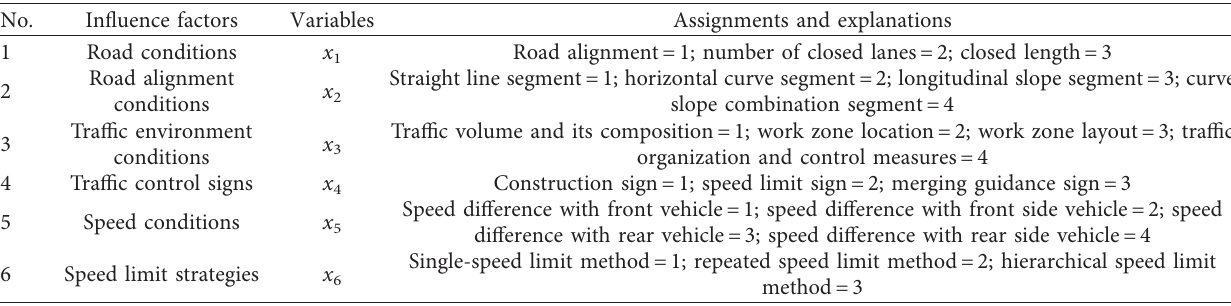
Table 2: Variable assignments and explanations of factors influencing drivers’ preference to choosing merging behavior in work zones.